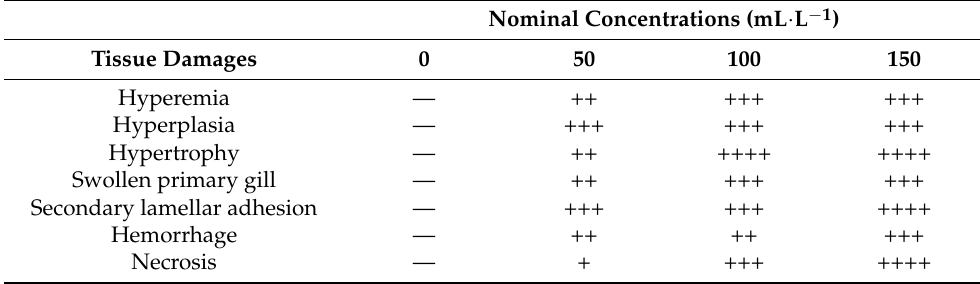
Table 2. Gill damages in common carp ( Cyprinus carpio ) after 96 h exposure to commercial formulation of glyphosate (glyphosate Aria 41% SL— suspension).